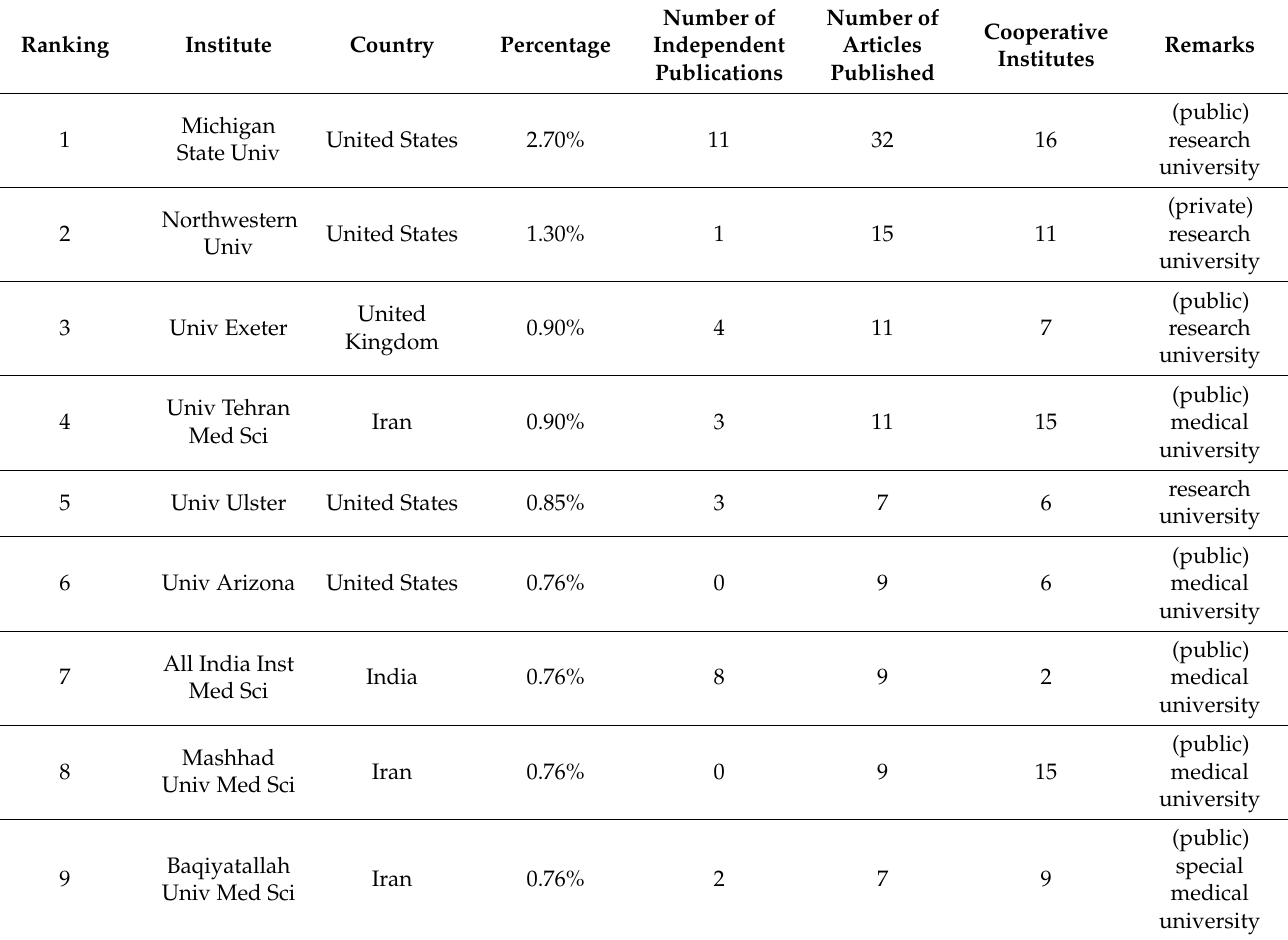
Table 3. The top 15 research institutions in terms of the number of articles published on foot reflexology.